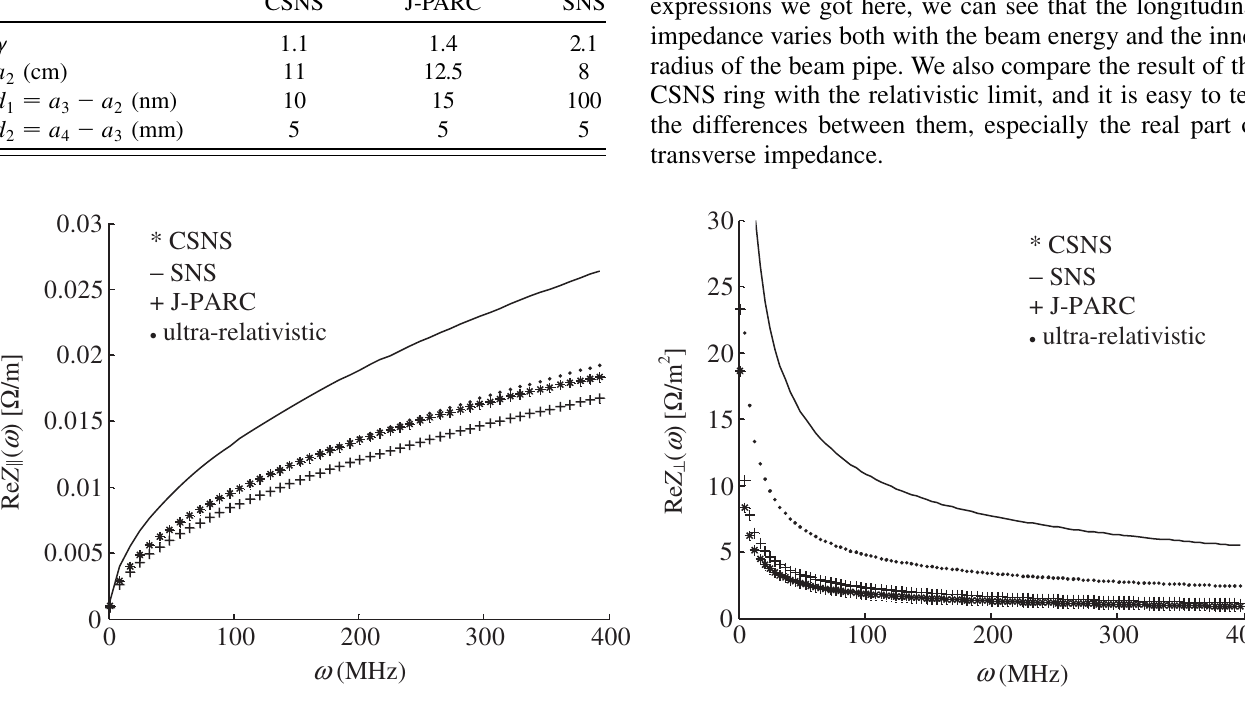
FIG. 2. Real part of longitudinal (left) and transverse (right) impedance per unit length for typical